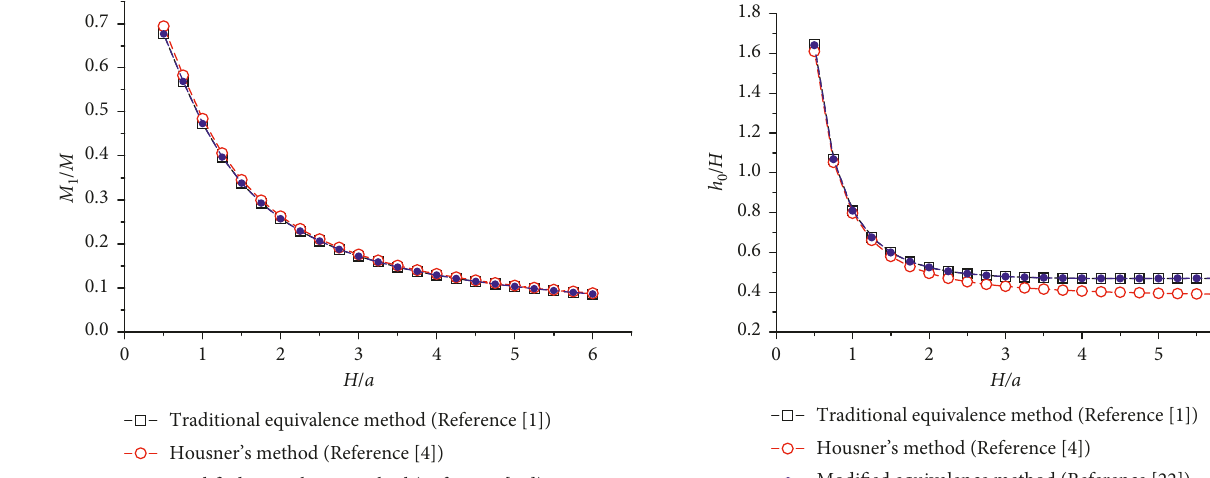
/ H vs. the fluid depth ratio H / a 0